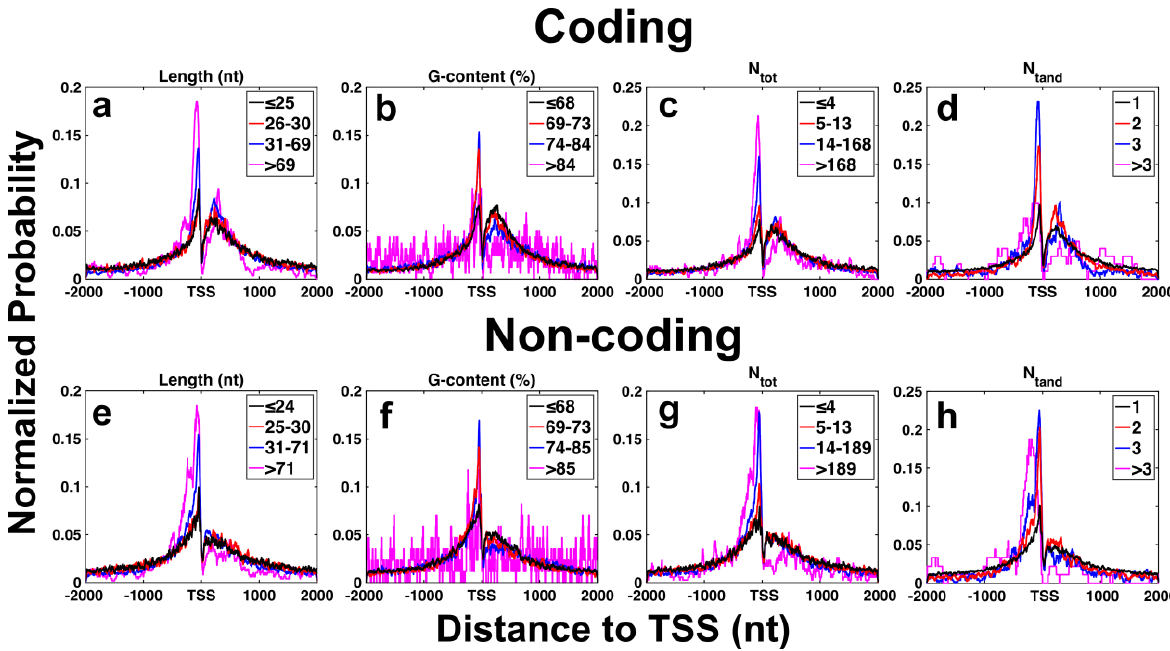
Figure 6. Likelihood that a residue lies within a G4CR possessing certain characteristics, plotted as a function of the residue’s position relative to the transcription start site (TSS), for human gene promoters. Colors represent the bottom 50% of G4CRs (black), 50 – 75% of G4CR, 76 – 99%, and top 1% of G4CRs. Specific values are given in the legend of each panel. Panels ( a – d ) are for the coding strand (length, G-content, N tot , and N tand, respectively). Panels ( e – h ) are for the non-coding strand (length, G-content, N tot , and N tand, respectively).